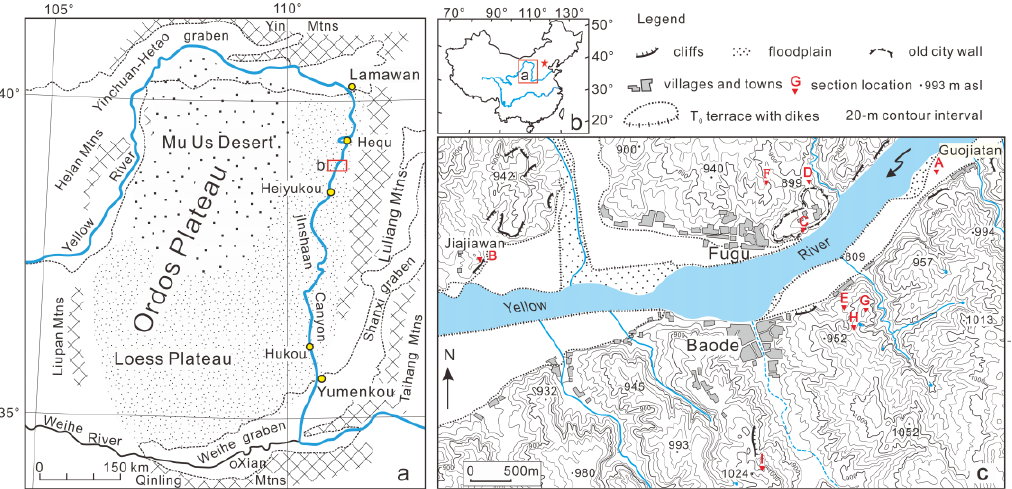
Figure 1. ( a , b ) Map showing the Yellow River course along the margins of the Ordos Plateau and location of the study area (Baode); ( c ) topographic map showing the localities of the sections (A–I) shown in Figure 2. The topographic map with contour intervals of 20 m was constructed based on a Chinese 1:50,000 topographic map (unpublished).